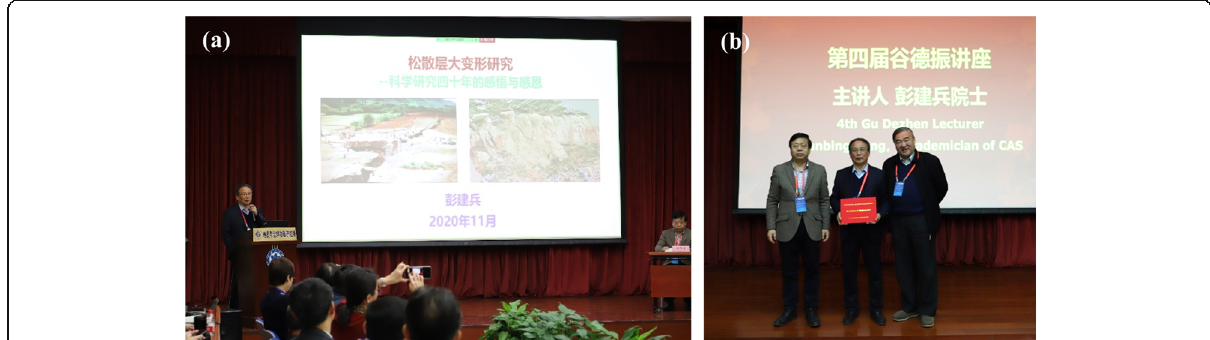
Fig. 4 Photos of Gu Dezhen Lecturer: ( a ) Prof. Jianbing Peng and ( b ) Group photo with the